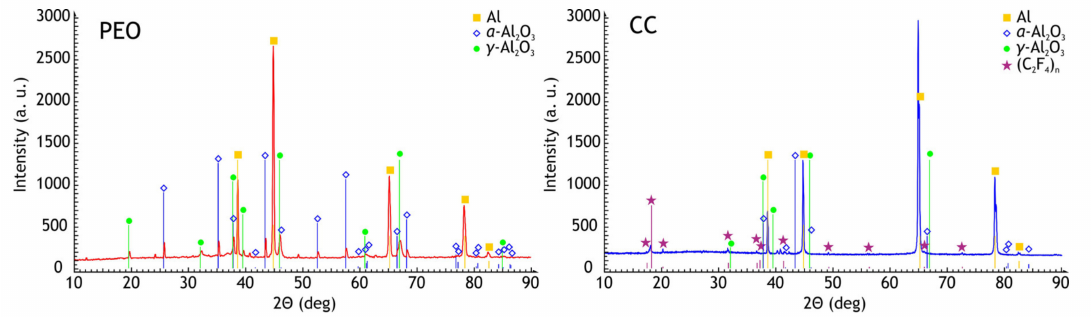
Figure 2. XRD spectra of PEO and composite